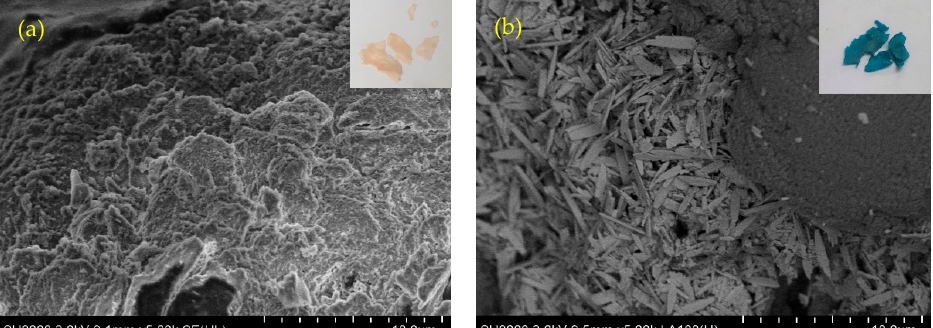
Figure 1. ( a ) FT ‐ IR spectra of pristine chitosan (CS), CS ‐ Ac ‐ An, and CS ‐ Ac ‐ An ‐ Cu(II) (after Figure 1. ( a ) FT-IR spectra of pristine chitosan (CS), CS-Ac-An, and CS-Ac-An-Cu(II) (after adsorption). adsorption). ( b ) 1 H ‐ NMR spectra of pristine chitosan (CS) and CS ‐ Ac ‐ An (before adsorption). ( b ) 1 H-NMR spectra of pristine chitosan (CS) and CS-Ac-An (before adsorption).